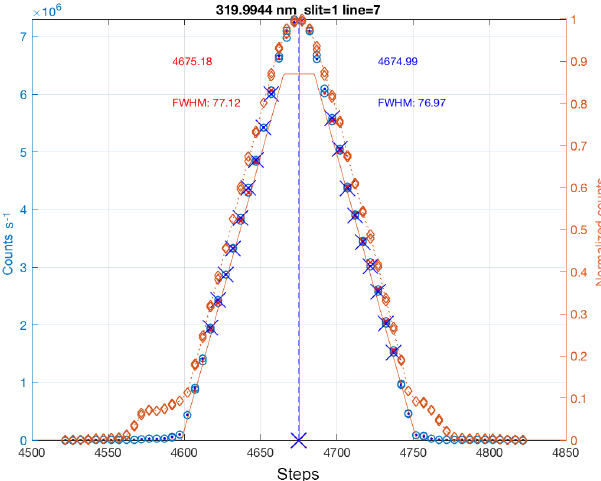
Figure 2. Slit function of the slit 3 (320nm) measured in the scan- ning mode: the standard method uses the normalized values only between 0.2 and 0.8 (points with crosses). The figure shows the signals recorded during the scans (orange diamonds) and the non- linearity-corrected values (blue circles) in countss − 1 . The hystere- sis is evident from the asymmetry of the uncorrected signals in the low signal region of the plot. The centre steps and the FWHMs cal- culated from the up-scan are shown in red while the values derived from the down-scanned slit function are presented in blue text. The central wavelength determination is not affected by the nonlinearity but the apparent FWHMs would be larger if the non-linearity cor- rection were not applied. The resulting parametrized slits are repre- sented on the right